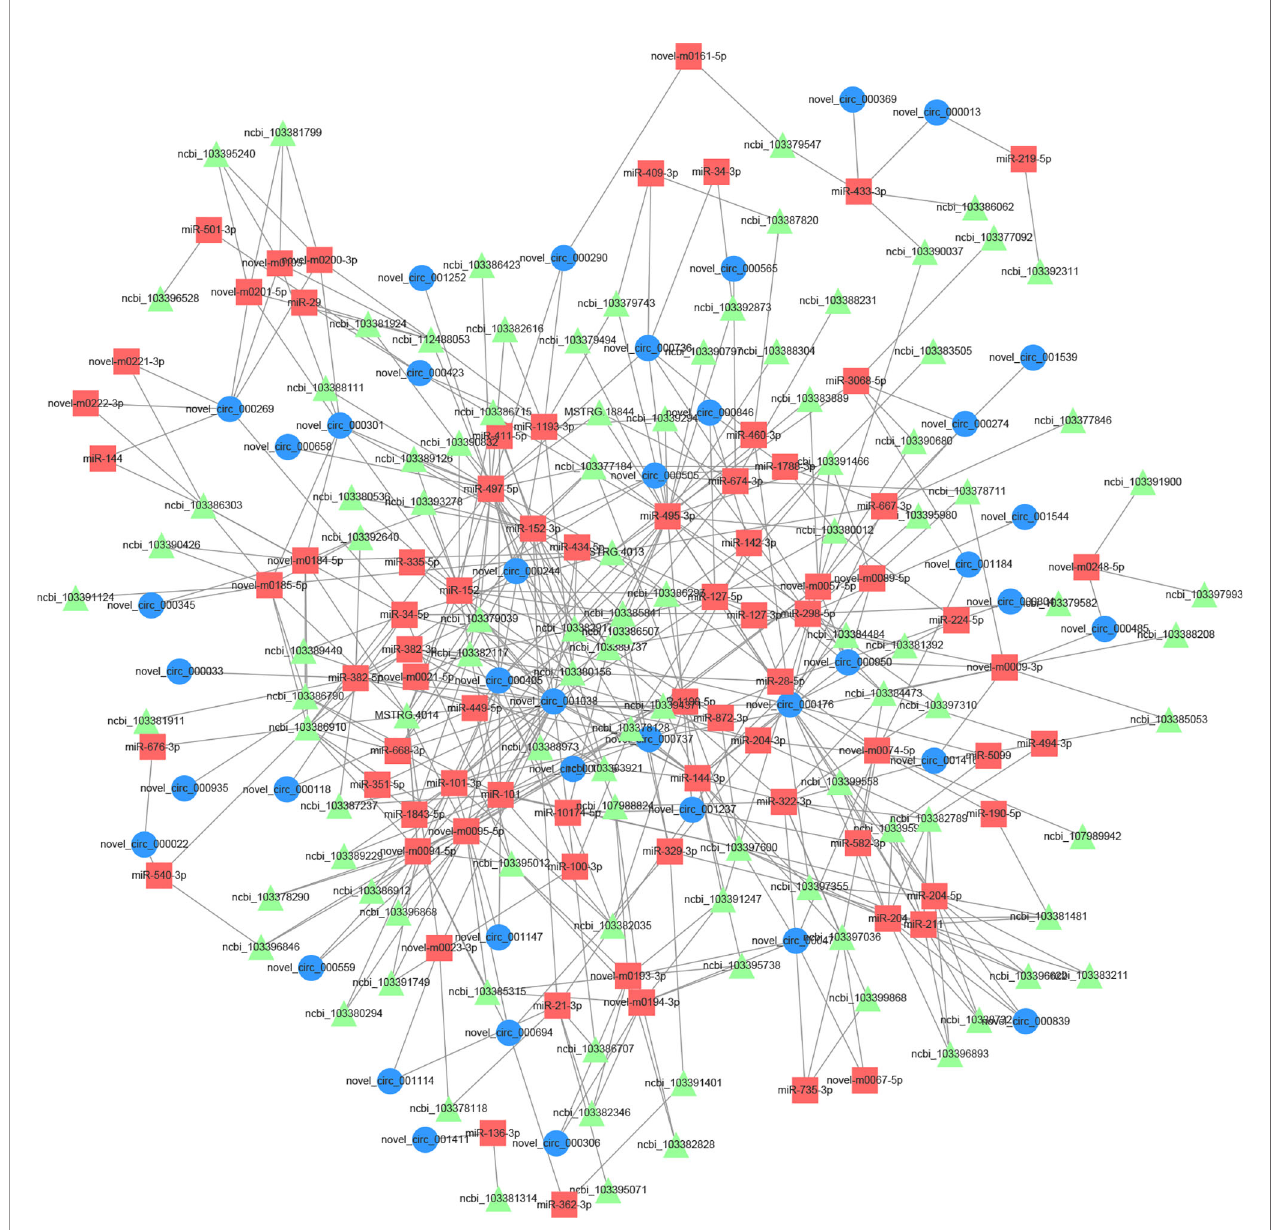
FIGURE 6 | The predicted biomathematical circular RNA (circRNA)-microRNA (miRNA)-messenger RNA (mRNA) networks associated with blind-side hypermelanosis in tongue